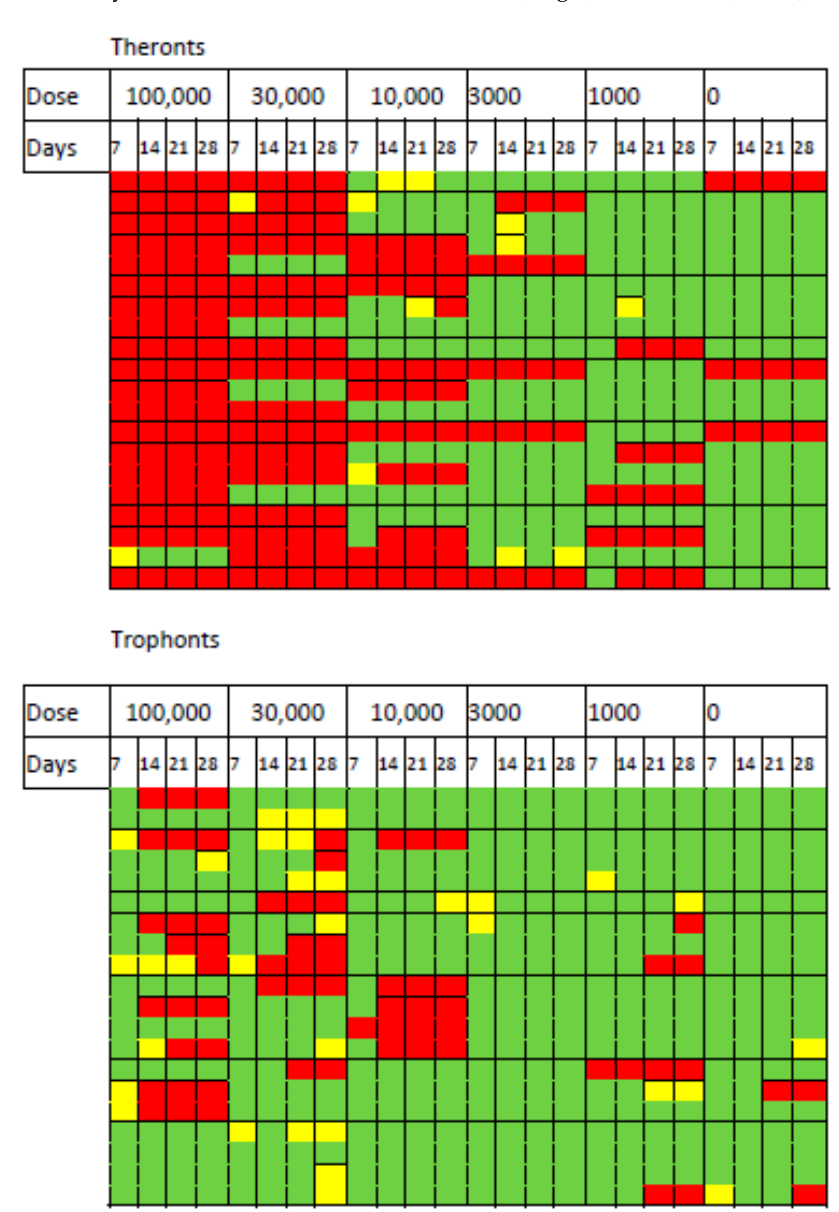
Figure 2. Heatmap showing response of slugs to exposure to different doses of Tetrahymena rostrata theronts and trophonts over 28 days of observation. Inhibition of feeding (yellow), death (red) or survival (green). Lines within treatments are for individual slugs.